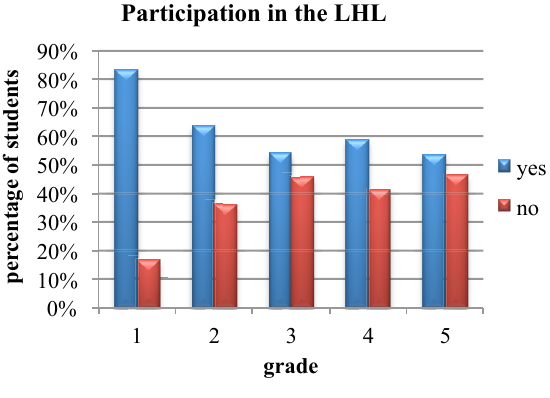
Fig. 6: Percentage of Students Receiving Each Grade Who Took Advantage of the LHL, Survey WS